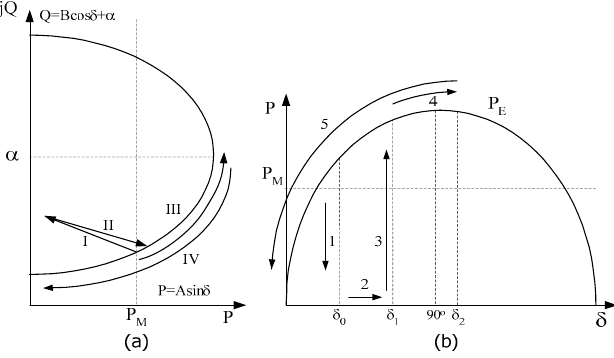
Figure 4. The trajectory in the complex power and power–angle plane. ( a ) P-Q curve, ( b ) P- δ curve .